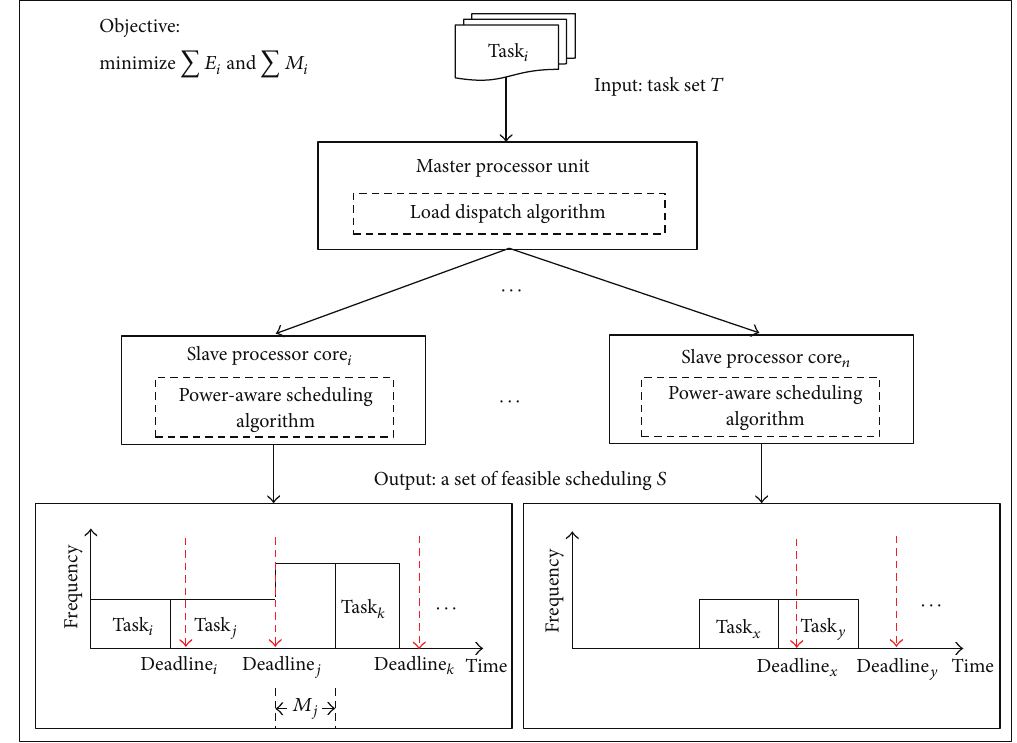
Figure 3: System